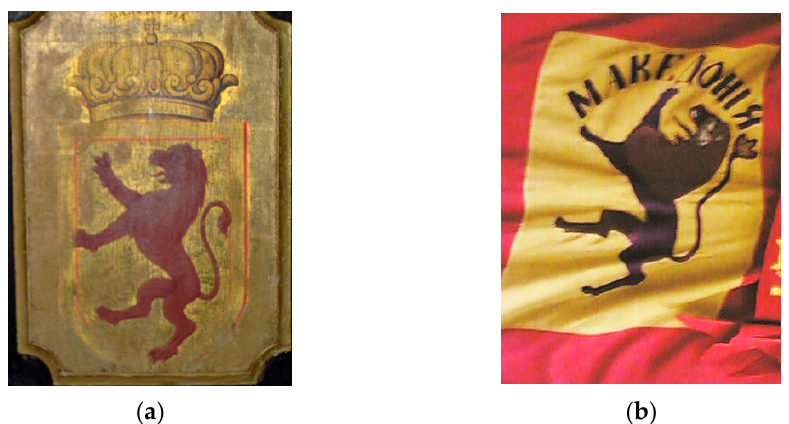
Figure 12. ( a ) Monastery of St. Ivan of Rila; ( b ) Flag of the Razlovci Uprising of 1876.